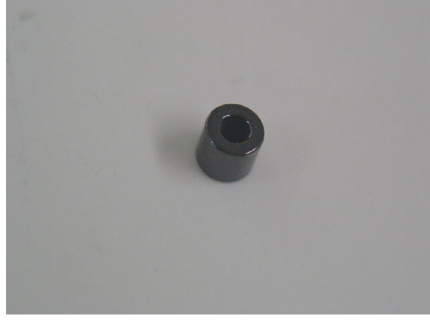
Figure 17. Black ceramic bracelet component E.